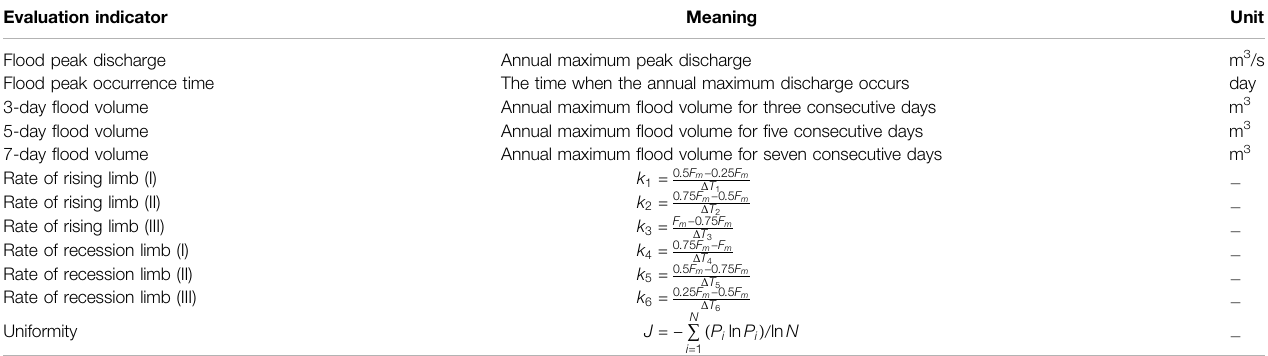
TABLE 2 | Meanings of evaluation indicators extracted from the annual typical fl ood event. Evaluation